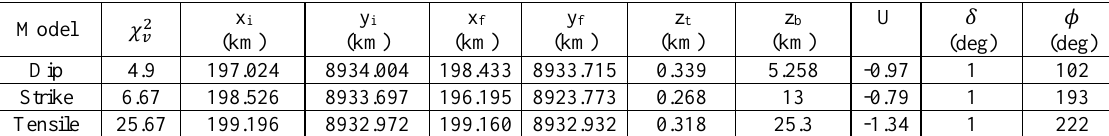
Table 1. Parameters of best fit spheroidal sources.